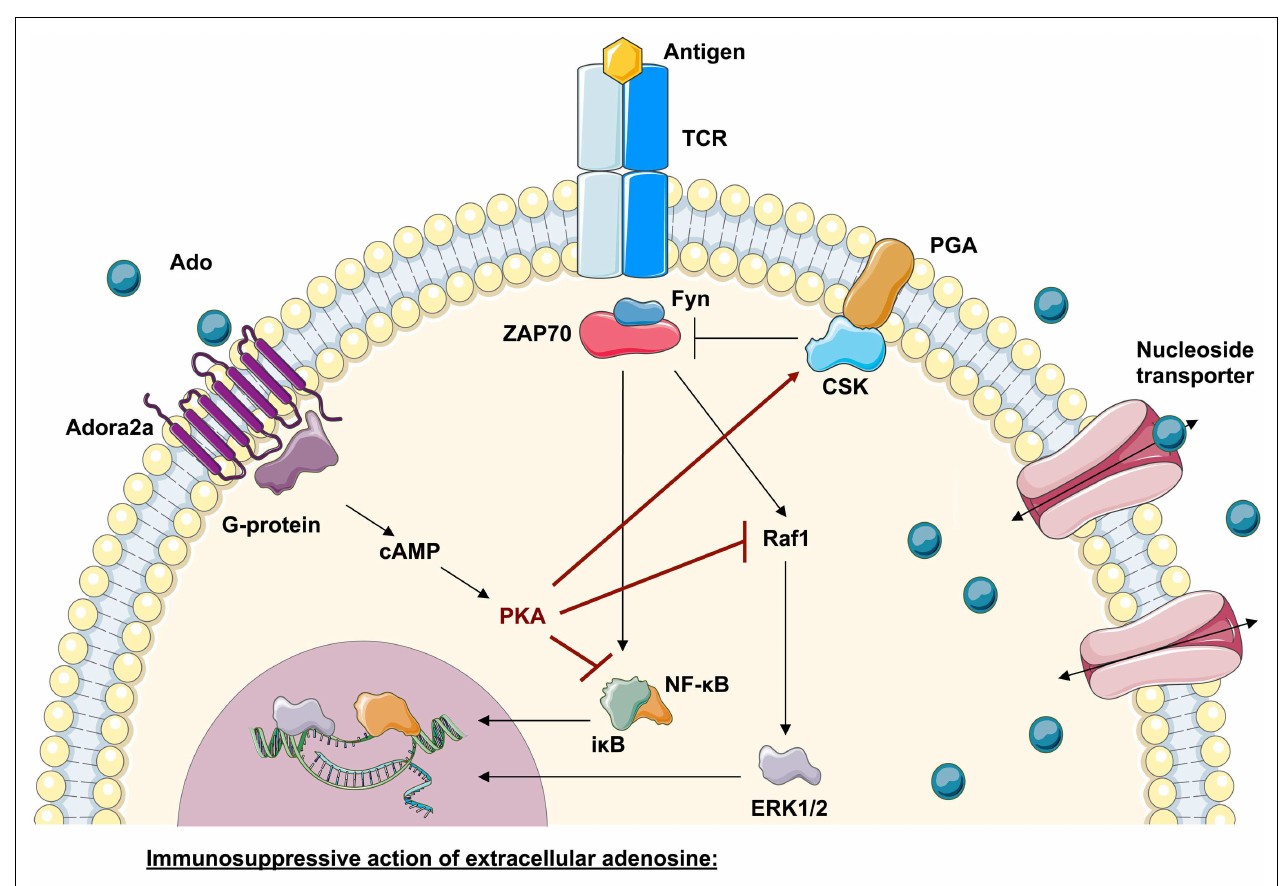
that the inhibitory properties of PKA are mediated via activation of Csk or inhibition of Raf1. Consistently it has been shown that the severely compromised effector functions in ADA-deficientT cells associates with an intrinsically reduced ERK1/2 signaling, a decreased phosphorylation of I κ B and an altered nuclear recruitment of NF- κ B.This suggests that the accumulating adenosine levels in an ADA-deficient environment can directly antagonize biochemical events arising fromTCR